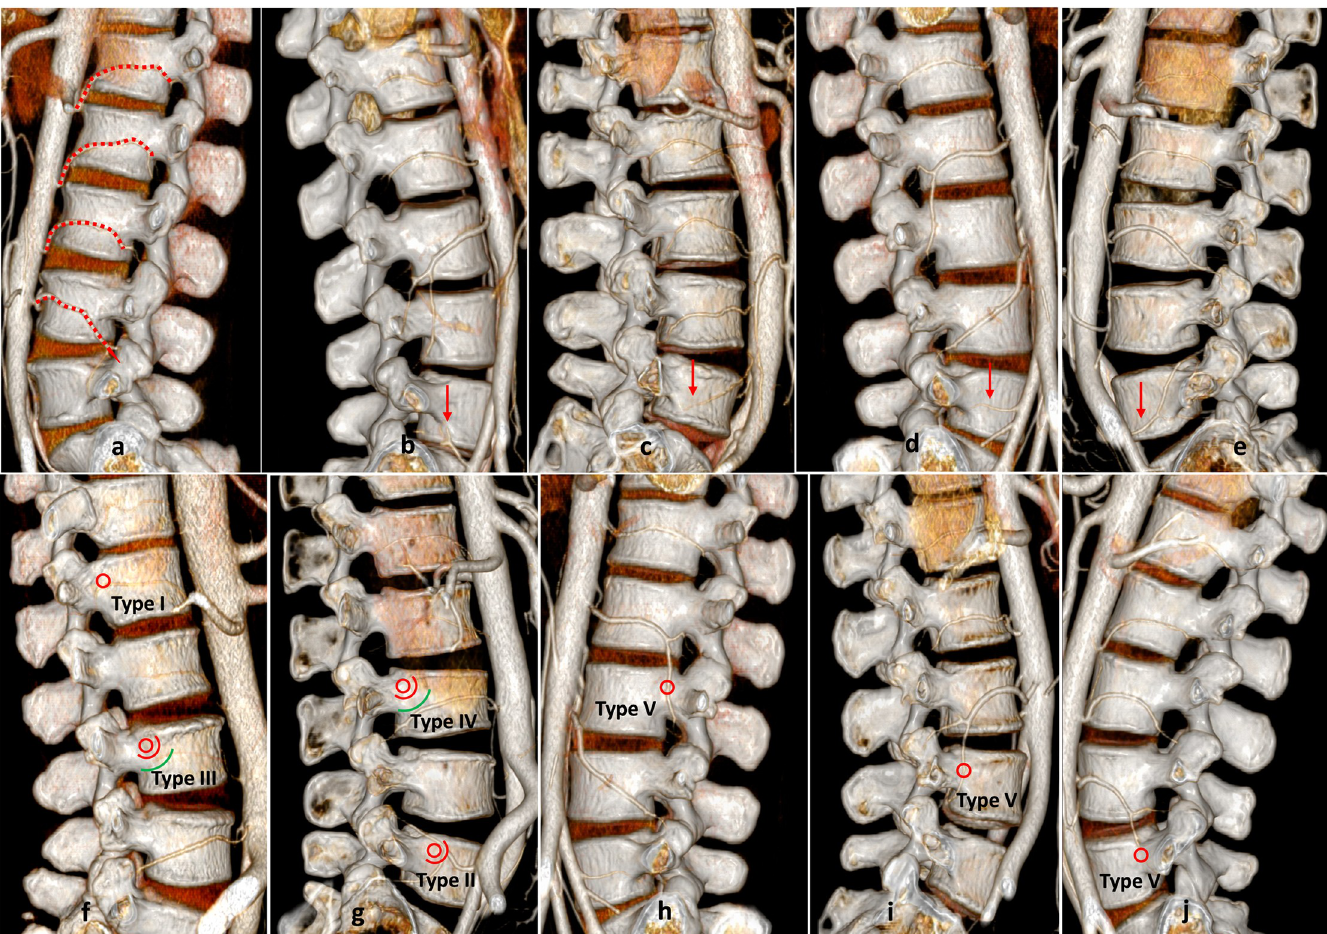
Fig 3. The origin of the 5 th LA and Type I-V LA. a, LA on the lateral side of the vertebral body in L1-L4. b, the 5 th LA originated from the iliolumbar artery. c, the 5 th LA originated from the abdominal aorta. d, the 5 th LA originated from the internal iliac vein. e, the 5 th LA originated from the common iliac artery. f, Type I LA in L1, Type III LA in L3. g, Type II LA in L5, Type IV LA in L3. h, Type V LA in L3. i, Type V LA in L4. j, Type V LA in